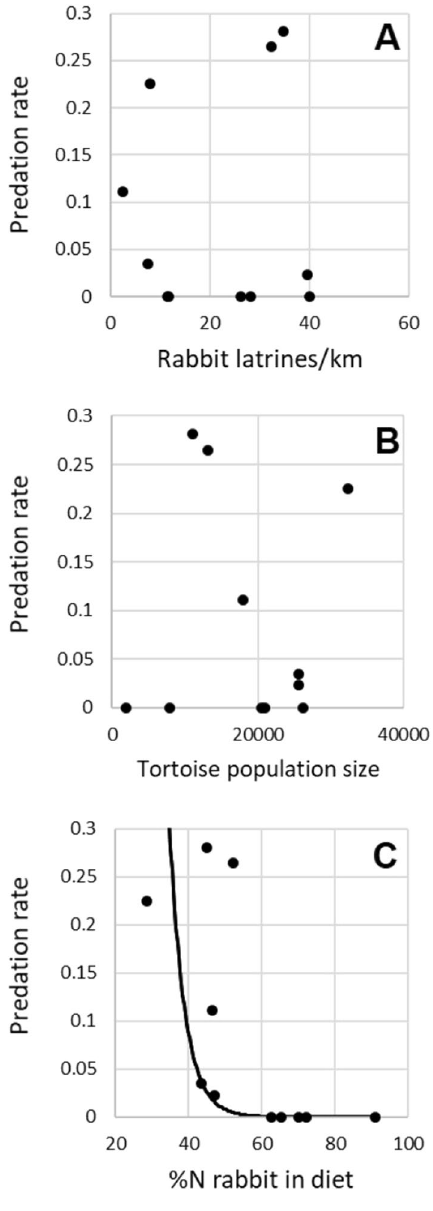
Figure 5. Relationships between predation rate on spur-thighed tortoise by golden eagle and ( A ) tortoise abundance within the 5 km eagle territorial radius (functional response), ( B ) %N of rabbit in eagles’ diet, and ( C ) rabbit abundance index. n = 11 golden eagle territories with sufficient diet data (for territories with > 1 year sampled, mean values are represented). Only case ( B )showed a significant relationship ( R 2 = 0.72, P = 0.001). Territories T1 and T5 (see text) are shown in case ( C